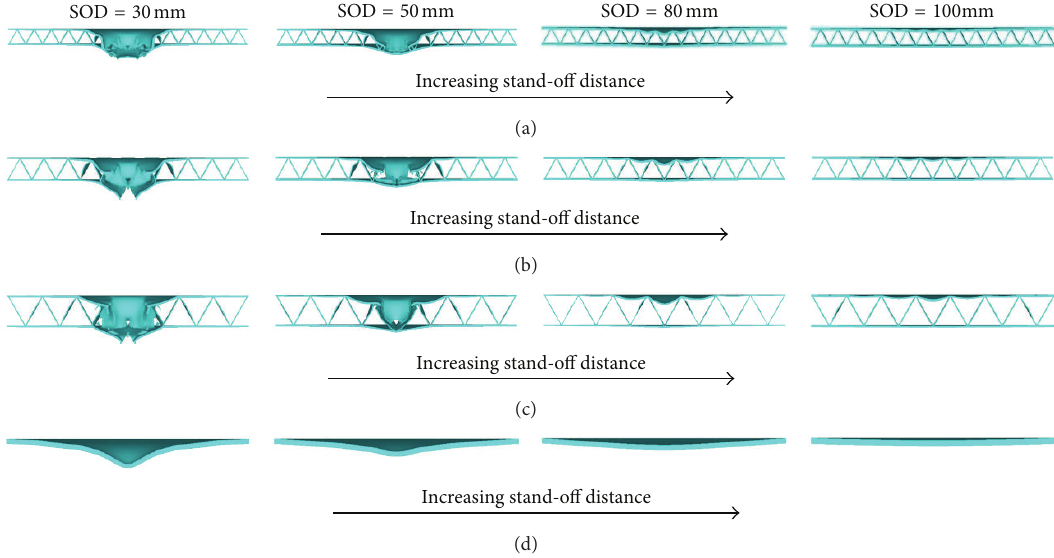
= 2.0 mm, 𝑡 = 1.0 mm, and 𝑙 = 28 mm; (c) 𝑡 𝑓 𝑐